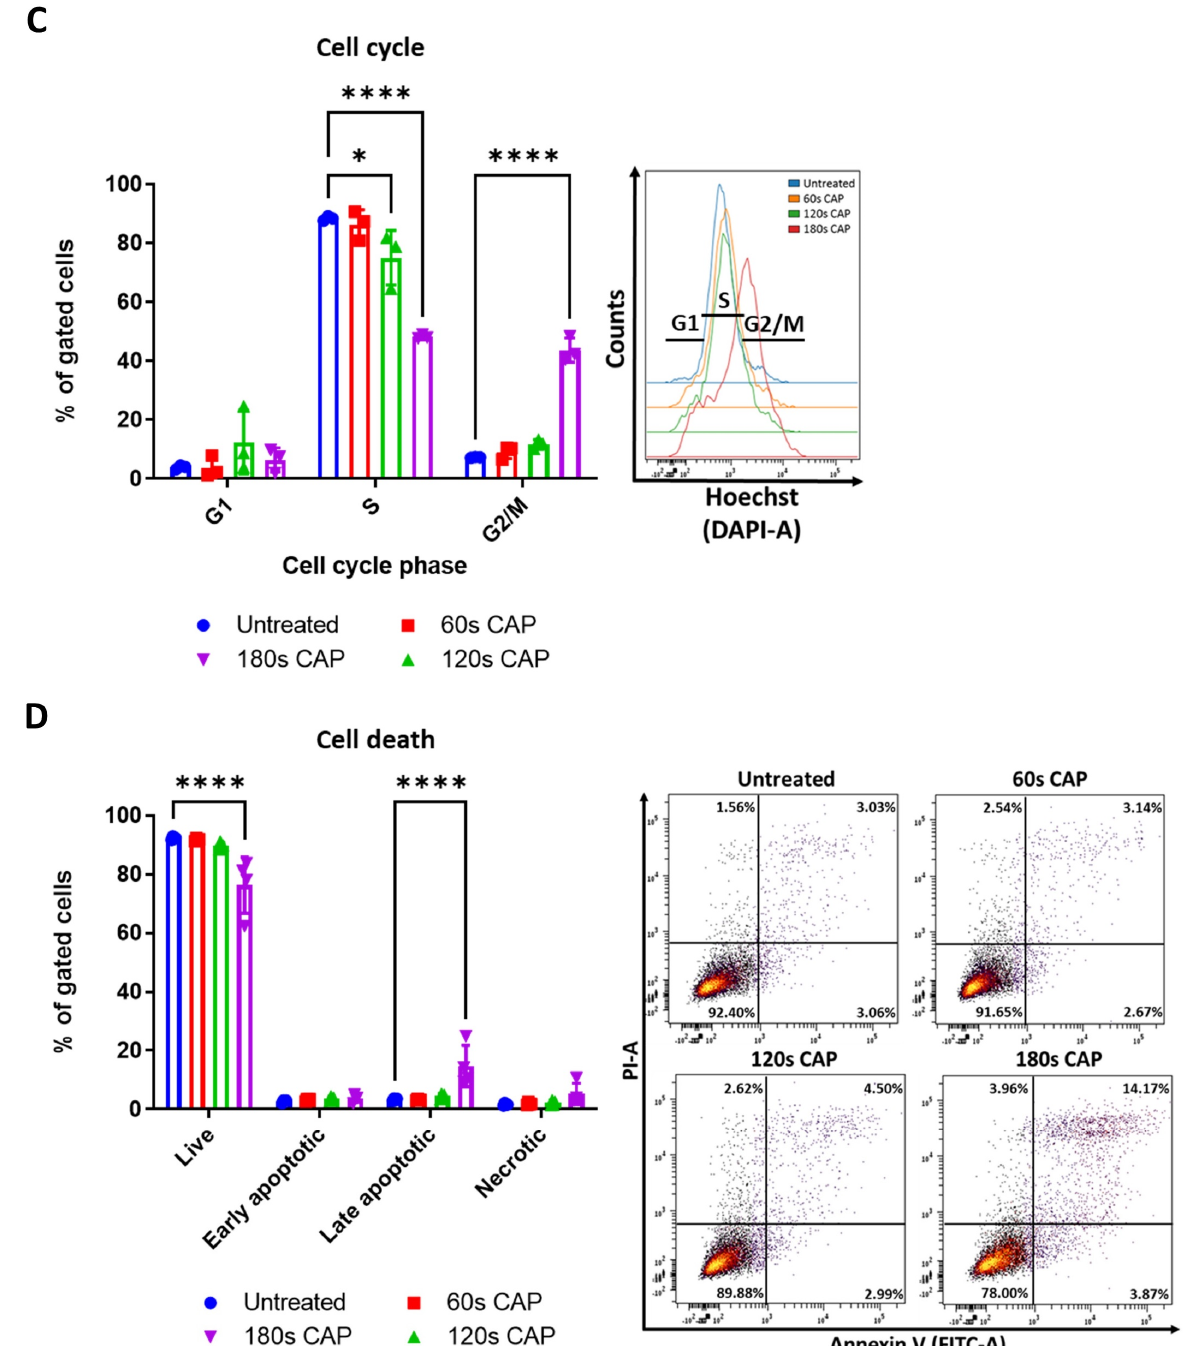
Figure 1. CAP treatment reduces the viability and proliferation of the human melanoma cell lines, Ma-Mel-19 and UKRV-Mel-15a, in a dose-dependent manner. ( A , B ) CFSE prelabeled Ma-Mel-19 and UKRV-Mel-15a cells were treated with varying amounts of CAP (60 s, 120 s, 180 s). After 3 days, cells were analyzed via flow cytometry; ( A ) cells were stained for viability. Bar diagram shows the average percentage of live cells measured ( n = 3) ± SD; ( B ) bar diagram shows the average CFSE mean fluorescent intensity (MFI) measured, normalized to the untreated control ( n = 3) ± SD; ( C , D ) Ma-Mel-19 cells were treated with varying amounts of CAP (60 s, 120 s, 180 s). After 3 days, cells were analyzed via flow cytometry; ( C ) cells were stained with Hoechst. Bar diagram shows the percentage of cells in each gate ( n = 3) ± SD; ( D ) cells were stained with annexin V and propidium iodide (PI). Bar diagram shows the percentage of cells in each quadrant gate ( n = 4) ± SD. The